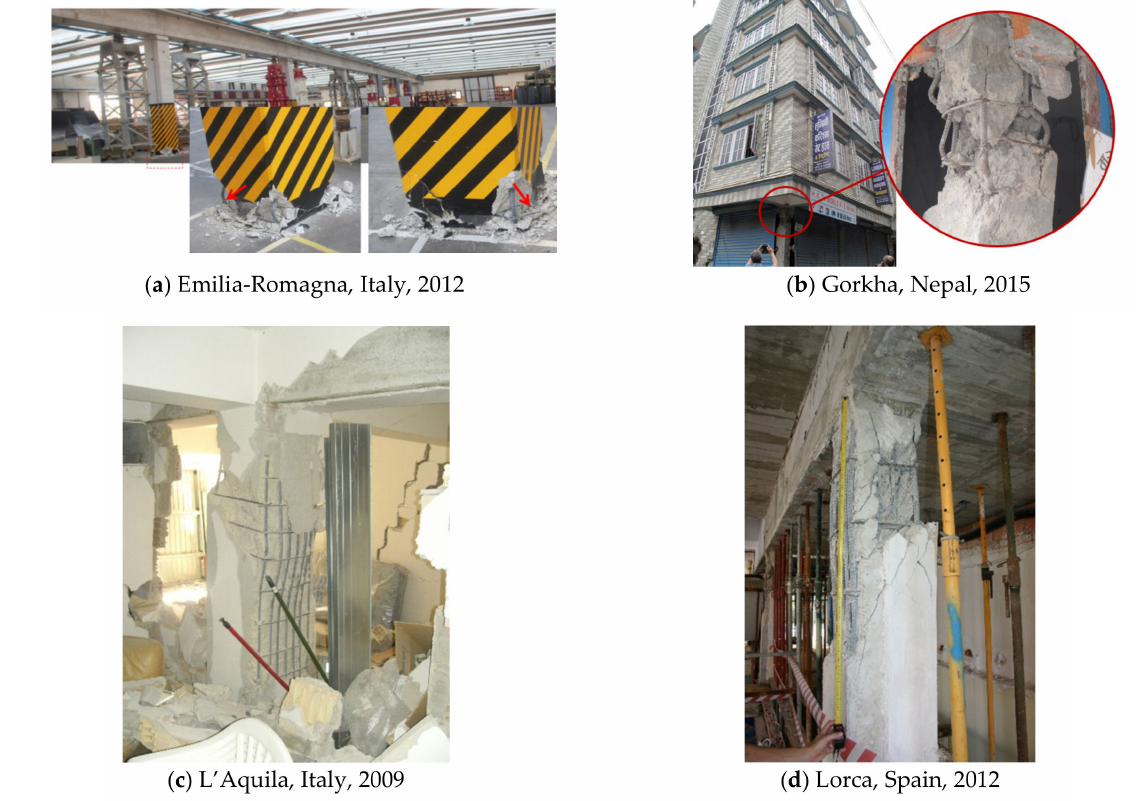
Figure 4. Damage type 1—example of post-earthquake damage in RC columns: ( a ) absence of transverse reinforcement, ( b ) hoops’ poor detailing, ( c ) large spacing between stirrups and ( d ) insufficient transverse